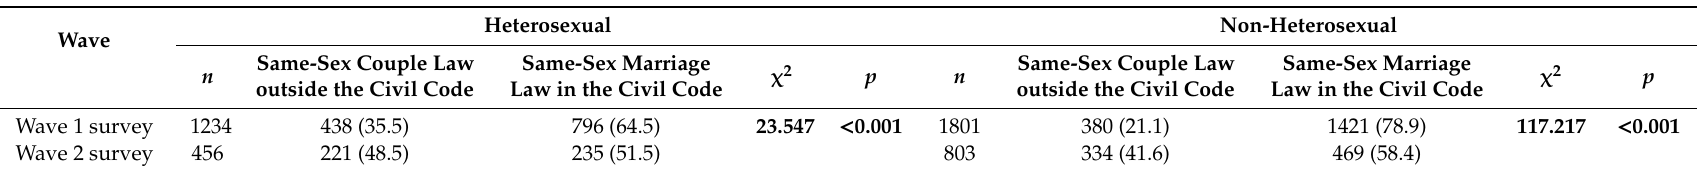
Table 2. Comparison of preferences of laws for the legal recognition of same-sex relationships in heterosexual and non-heterosexual participants supporting the legal recognition of same-sex relationships between Wave 1 and Wave